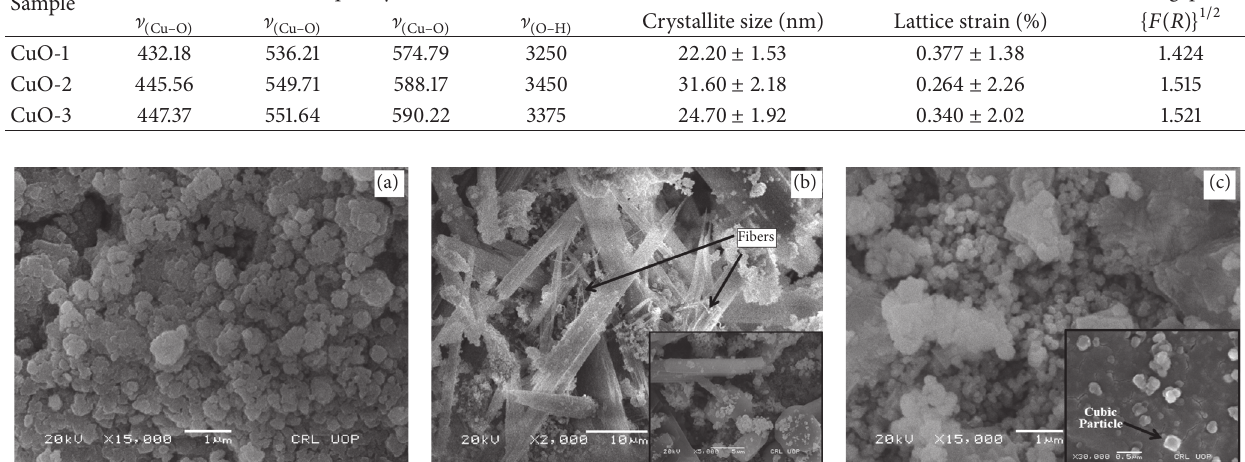
Figure 2: SEM micrographs of CuO NPs samples CuO-1 (a), CuO-2 (b), and CuO-3 (c) prepared using extracts of wastes of Cauliflower and Potatoes and Peas peels, respectively.